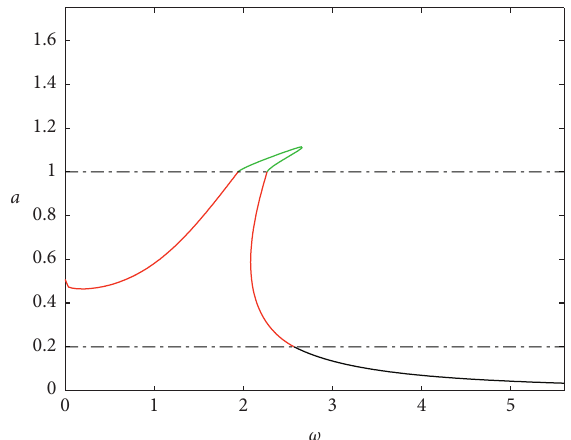
Figure 2: System amplitude frequency response curve and its partial enlargement.